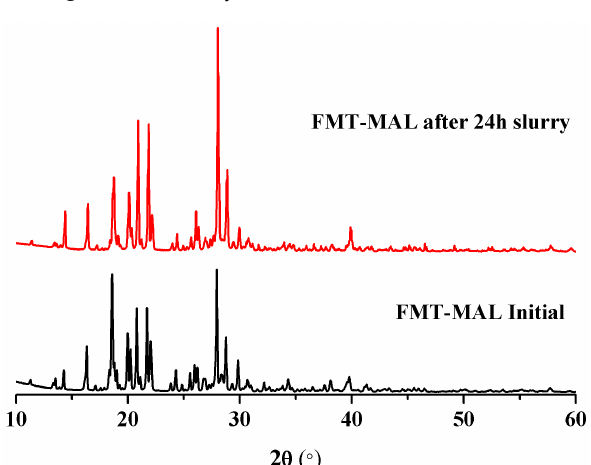
Figure 6. Solubility curves of FMT and FMT-MAL. Crystals 2019 , 9 , x FOR PEER REVIEW 10 of 12